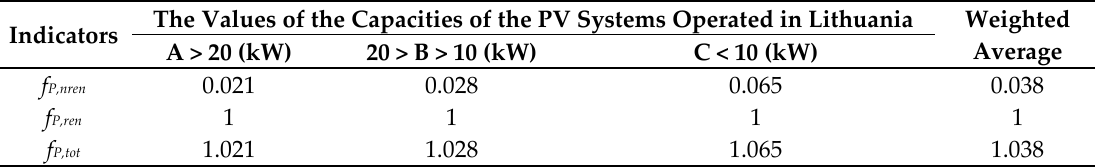
Table 1. The result of the PEF